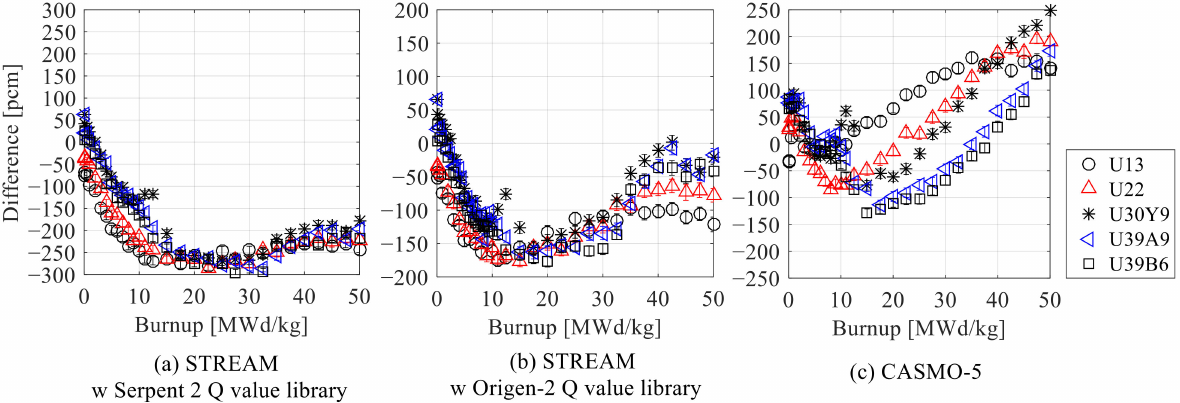
Figure 13. Evolution of k-inf discrepancies during depletion calculations. Reference is Serpent 2.